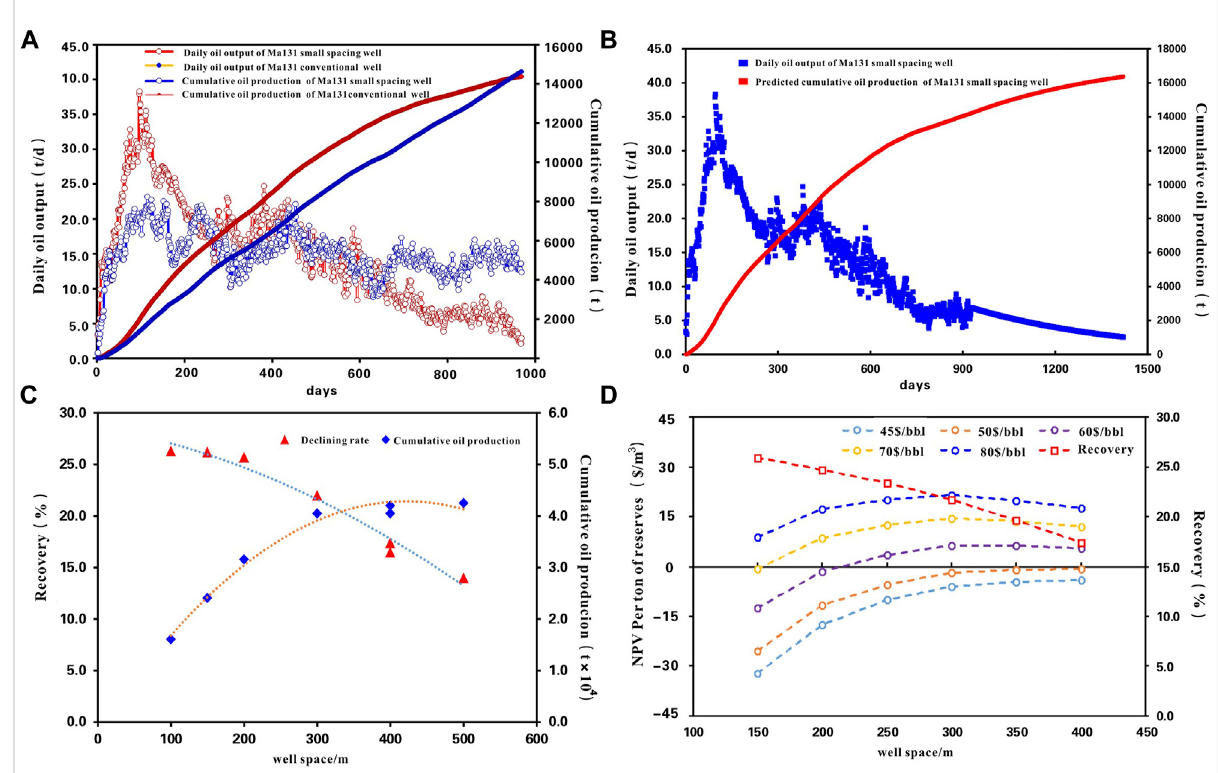
FIGURE 10 (A) The production difference between small-spacing wells and conventional wells in the Ma131 oil fi eld; (B) the daily output and predicted cumulative oil production of small-well-spacing pilot wells; (C) the relationships between recovery and cumulative oil production with well space; (D) the relationships between NPV and recovery with well